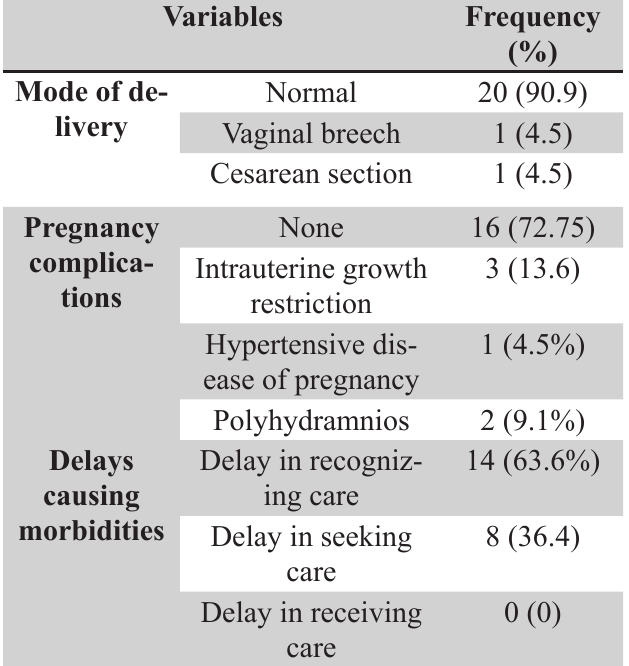
Table 3. Still births with birth defects and labor characteristics. (N=22).